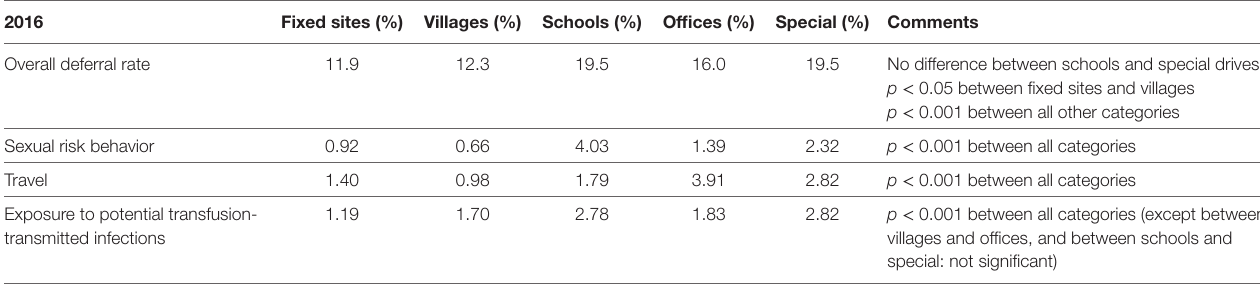
TaBle 5 | Comparison of donors’ deferral rate between fixed and mobile